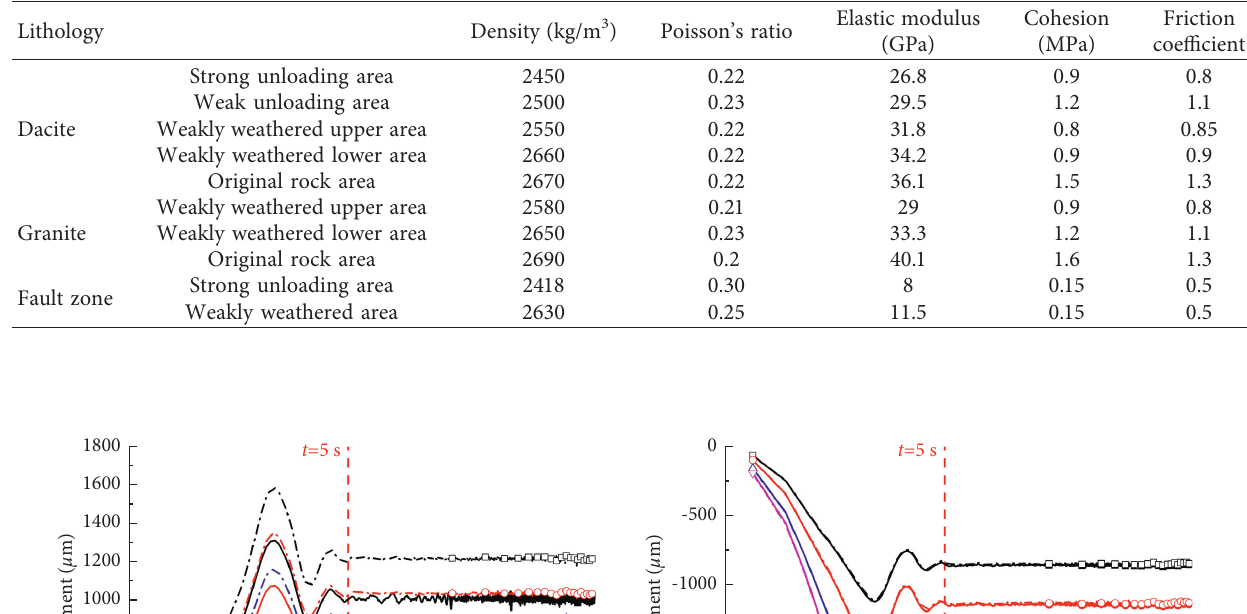
Table 3: Simulation